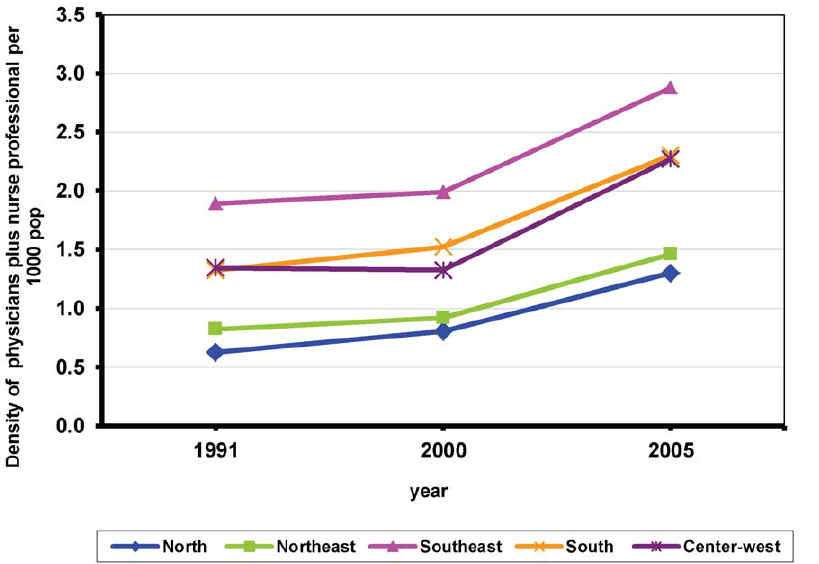
Figure 1. Trends of the density of physicians plus nurse professional per 1000 pop by region in Brazil 1991–2005. Author’s calculation using data of the population Census 1991 & 2000 and Datasus 2005 -Conselhos profissionais (Ministe´rio da Sau´de/SGTES/DEGERTS/CONPROF). Note: X axis=year. Y axis=density of physicians plus nurse professionals per 1000 pop. Blue diamond=North Region. Green square=Northeast Region. Purple cross=Centre West Region. Yellow cross=South Region. Pink triangle=Southeast Region.